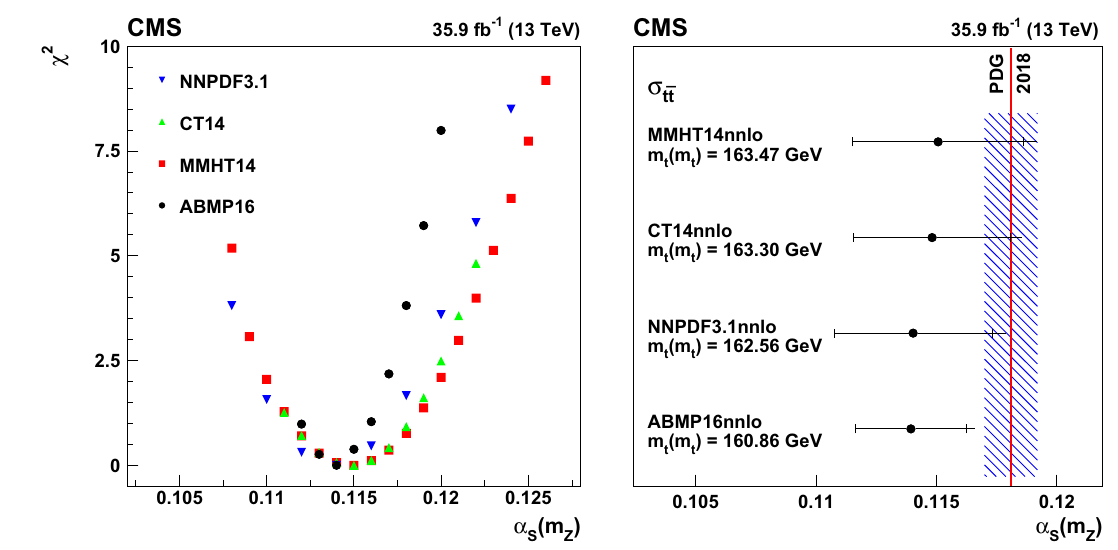
m t ( m t ) isgivenforeachPDFset.Theinnerhorizontalbarsonthepoints represent the experimental and PDF uncertainties added in quadrature. The outer horizontal bars show the total uncertainties. The vertical line displays the world-average α S ( m Z ) value [29], with the hatched band representing its uncertainty